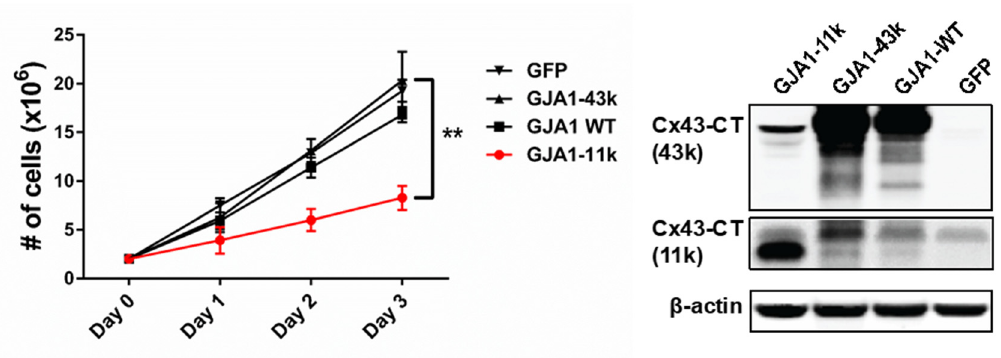
Figure 4: Effect of Cx43 short isoforms on cell proliferation. The overexpression of GJA1-11k inhibits the cell growth of the HEK293FT cell line. The growth curve is counts of transiently transfected cells each with vectors expressing GJA1-11k, GJA1-43k, GJA1-WT, and the negative control plasmid GFP with V5-tag. For each day data are presented as mean ± SEM, n = 12, ** p < 0.01 by one-way ANOVA followed by Tukey’s post-hoc test. Cell growth analysis revealed that cells expressing GJA1-11k grew significantly slower, than cells overexpressing other isoforms. Western Blot confirmed transient expression of Cx43 isoforms. Uncut immunoblots are provided in Figure S6.